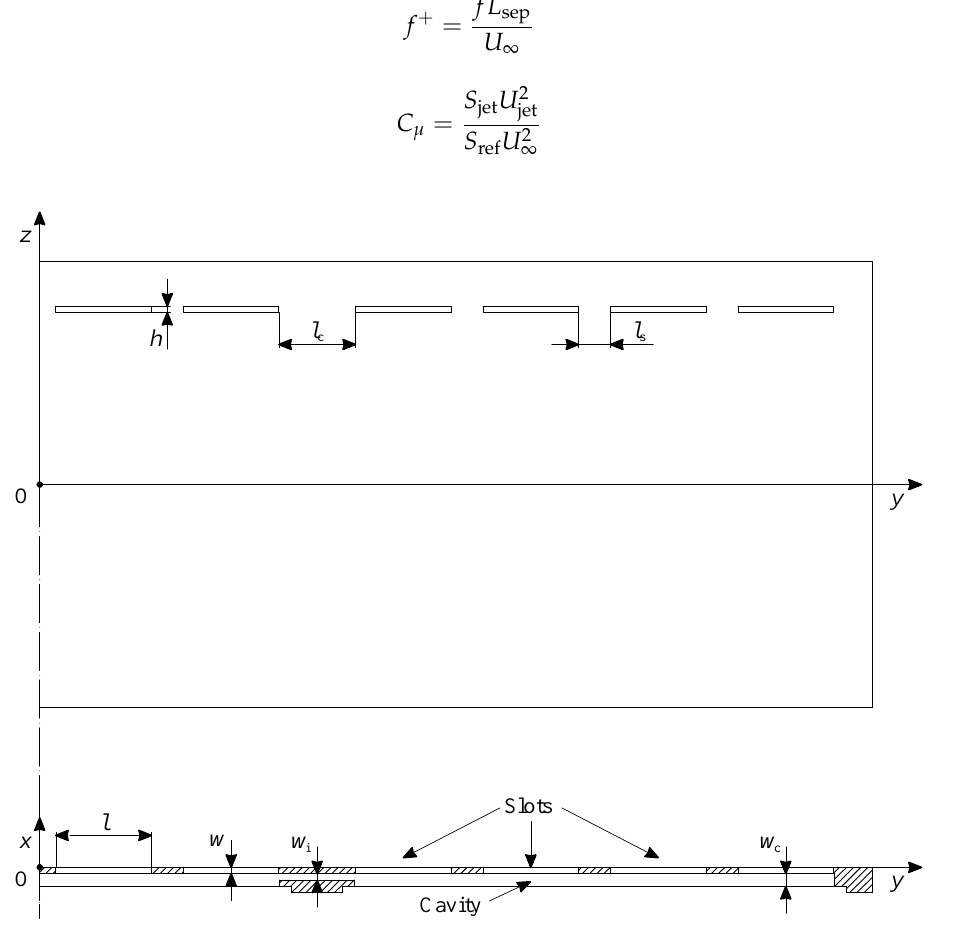
Figure 2. Reference frame and definition of the geometrical characteristics of the SJ